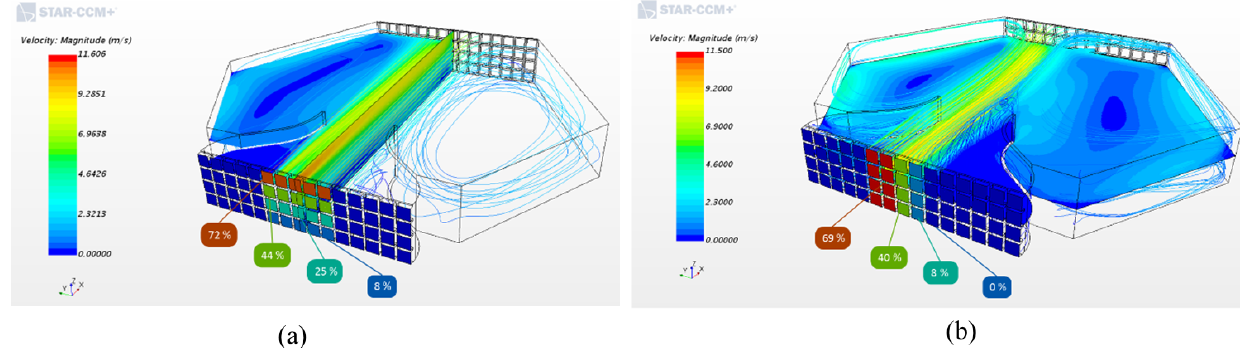
Figure 9. Fan setups for peak stages of extreme (a) vertical and (b) horizontal shears, prescribed for the scaled HAWT identical to the full-scale condition. The power set points for each row and column are included (just the five columns at the middle are